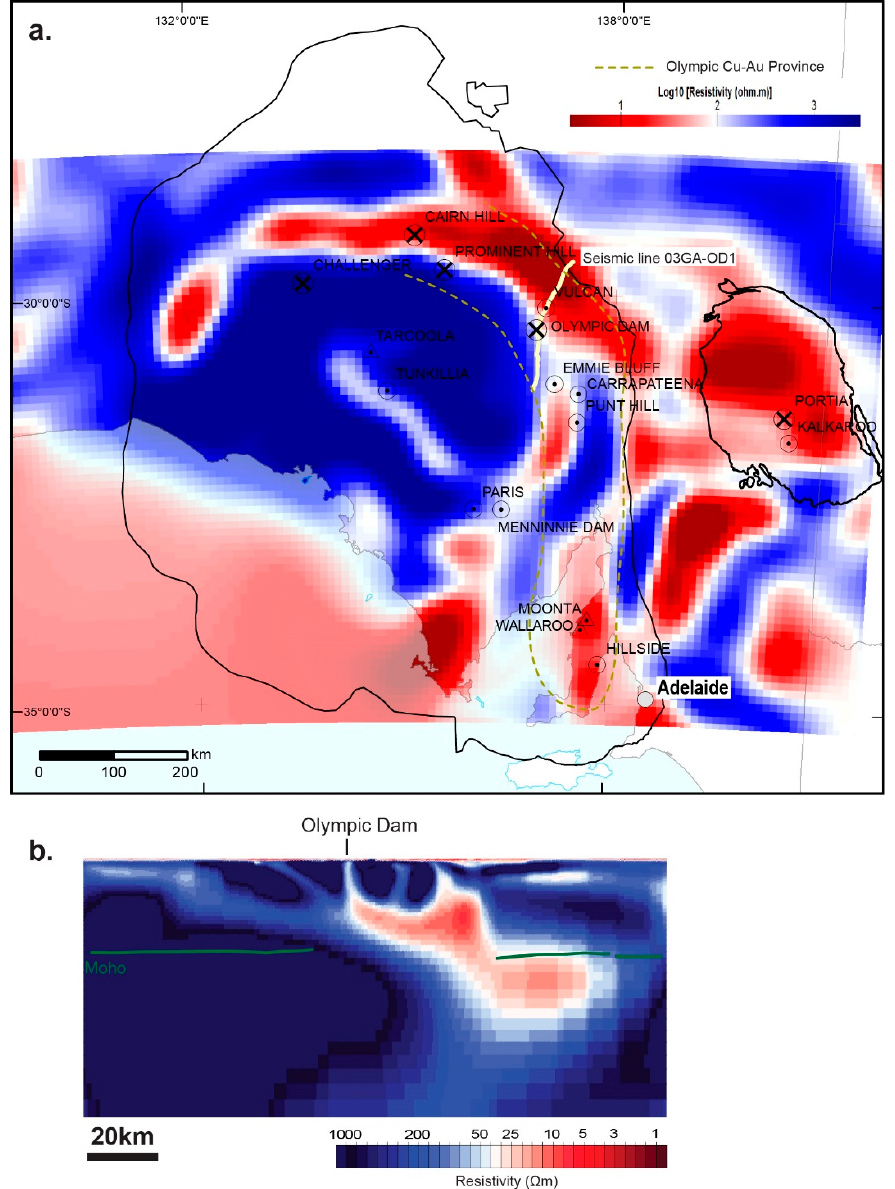
Figure 5. Resistivity model across the Gawler Craton and Curnamona Province. ( a ) Resistivity model at 55 km depth derived from AusLAMP magnetotelluric data [101]. ( b ) Resistivity model from detailed magnetotelluric sample sites at 1 km spacing parallel to seismic line 03GA-OD1. Modified from [93].